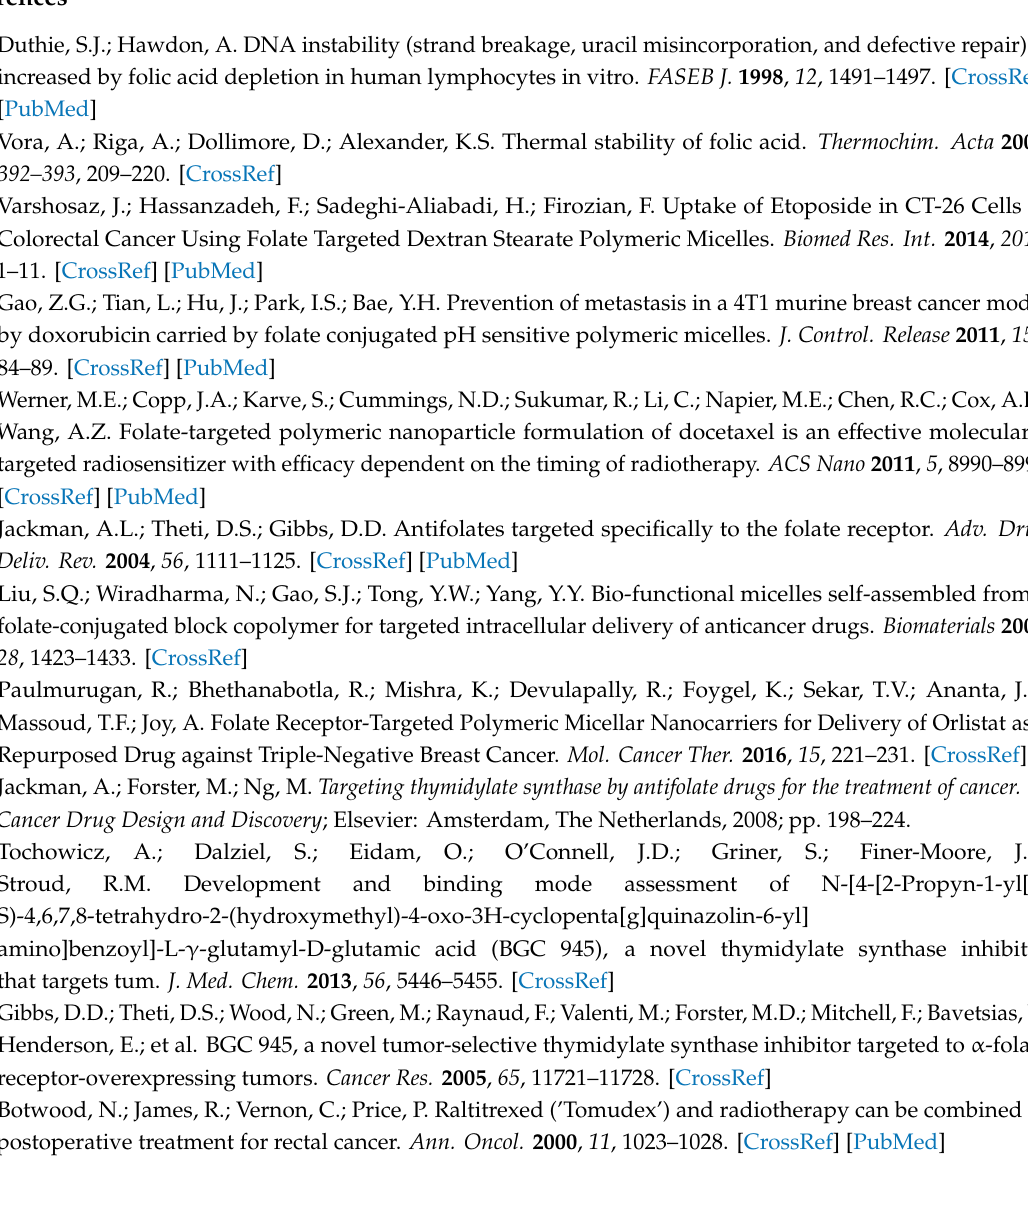
Figure S1: Transmission electron microscopy images of formed RTX NPs. Scale bar in lower magnification (larger image)—50 nm, scale bar in higher magnification image (inset)—20